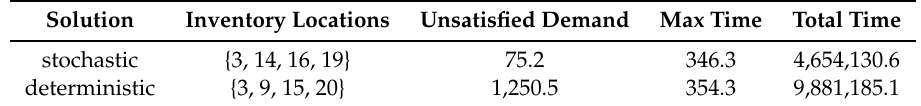
Table 5. Objective function values comparison between the stochastic and the deterministic